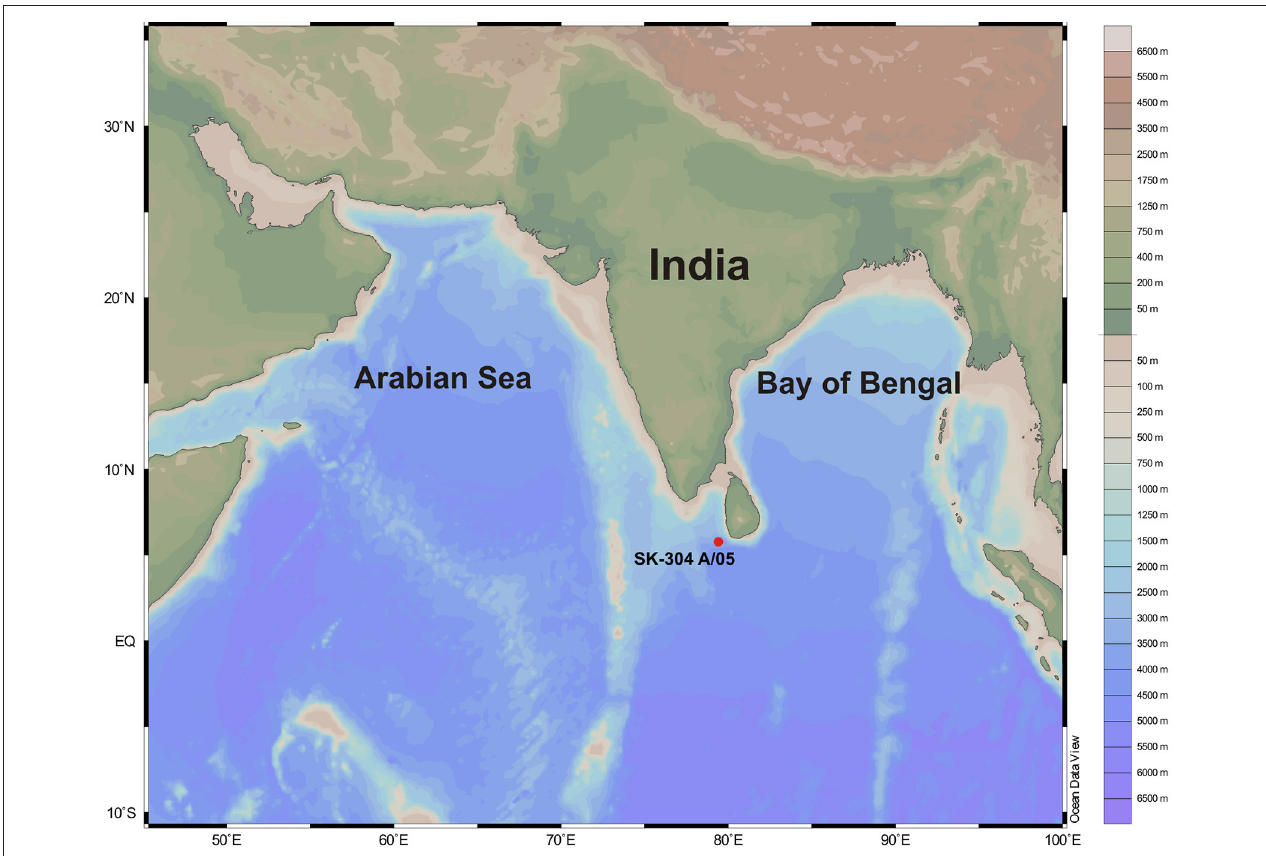
FIGURE 1 | Bathymetry map of Northern Indian Ocean with SK-304A/05 sediment core location retrieved during onboard ORV Sagarkanya. The sediment core lies at the mixing zone of the Arabian Sea and the Bay of Bengal near equatorial